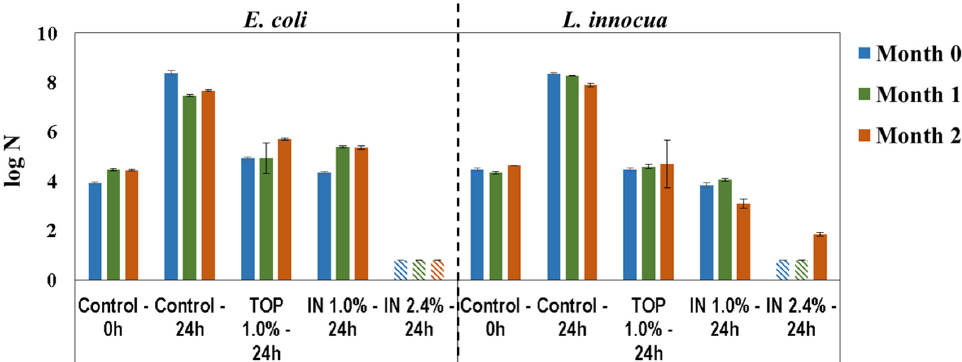
Figure 5. Antimicrobial activity of DPL towards E. coli and L. innocua , immediately after inoculation (0 h) and after incubation (24 h), on standard (control) and PHMB ‐ DPL newly produced (0 month), and after 1 and 2 months storage ( Below detection